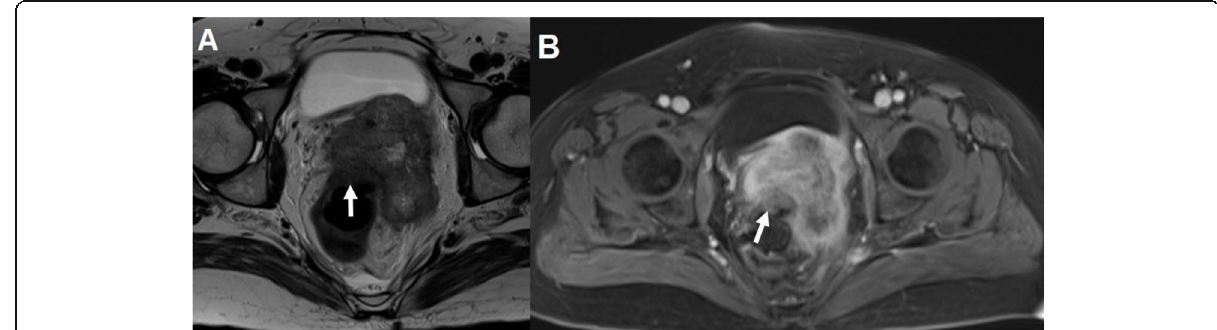
Fig. 6 Rectal invasion (arrows). A Axial T2WI showed disruption of their normal hypointense walls without a mass protruding into the lumen. B